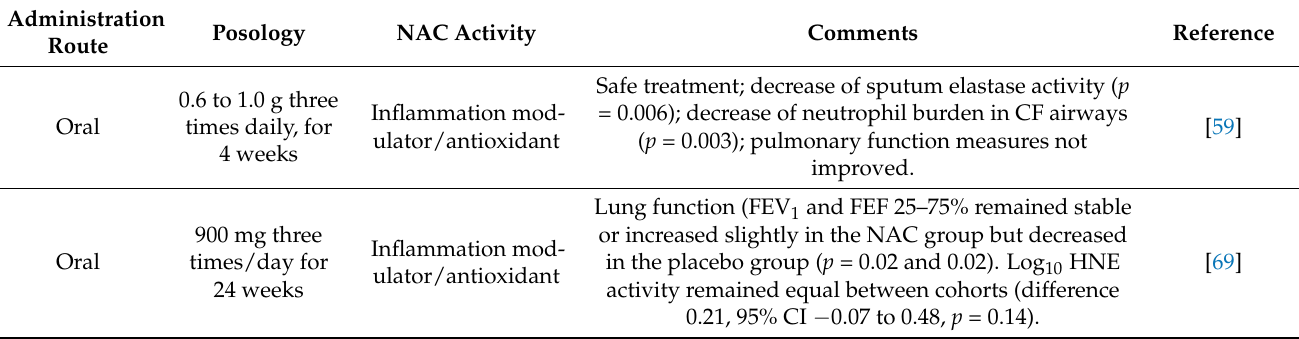
Table 2. N-acetylcysteine studies in vivo on CF patients in